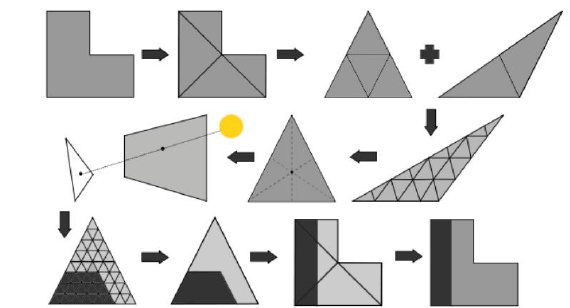
Figure 5. Sub-dividing surface/triangle into smaller triangles (Alam et. al., 2013).